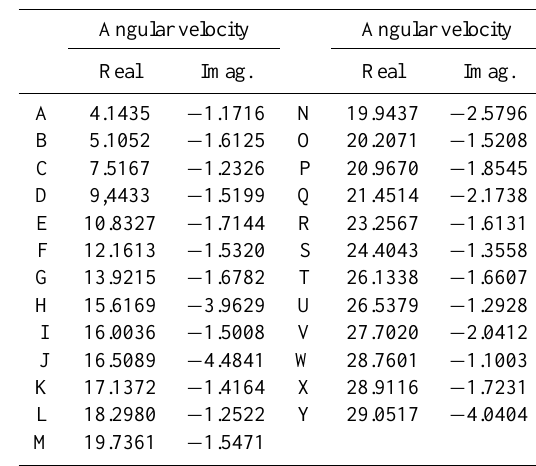
Table 2. Real and imaginary components of angular velocity (in radians per day) for the gravity wave